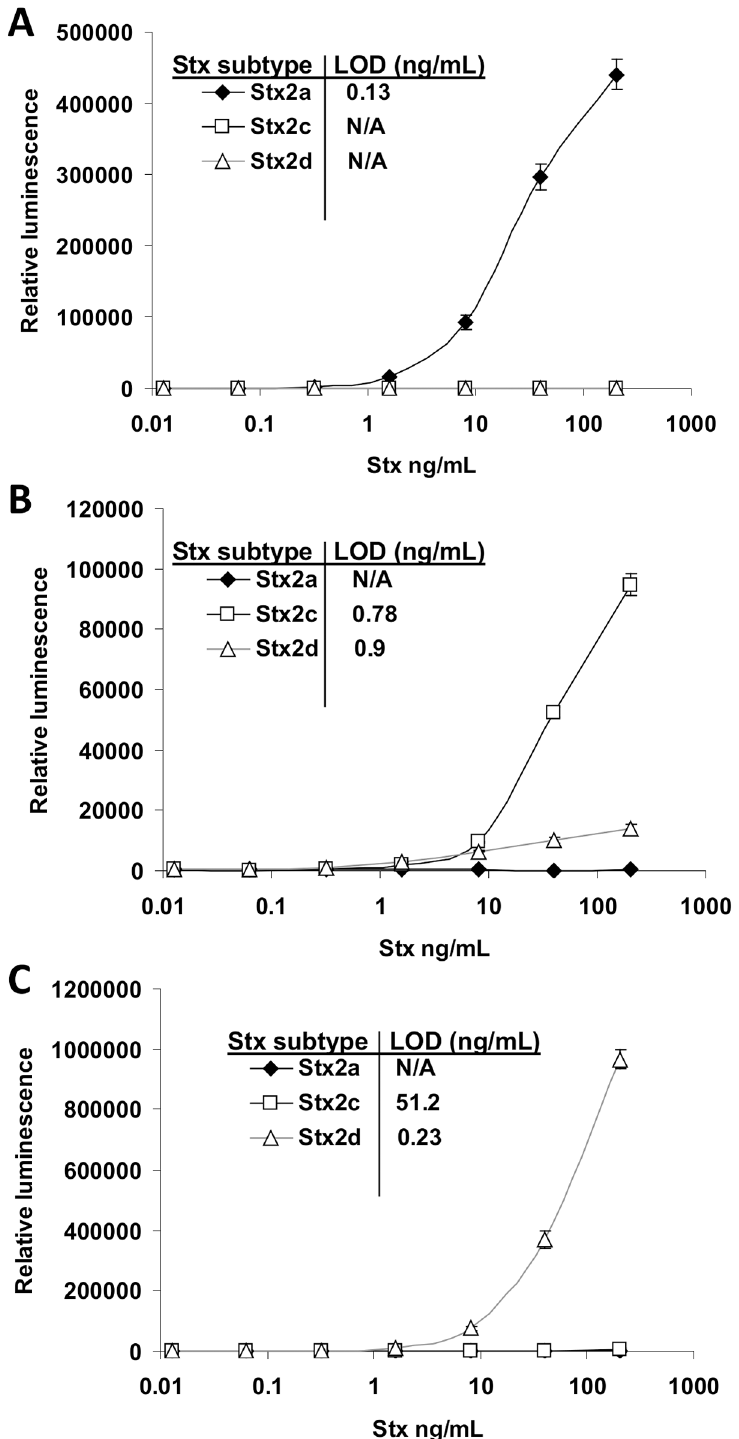
Fig 3. Stx2a-, Stx2c-, and Stx2d-specific ELISAs. A) A Stx2a-specific ELISA (Stx2-5 used for capture; Stx2-1 for detection) was conducted on pure Stx2a, Stx2c, and Stx2d. B) A Stx2c-specific ELISA (Stx2-5 for capture; Stx2e-2 for detection) was conducted on pure Stx2a, Stx2c, and Stx2d. C) A Stx2d-specific ELISA (Stx2e-3 for capture; Stx2e-2 for detection) was conducted on pure Stx2a, Stx2c, and Stx2d.